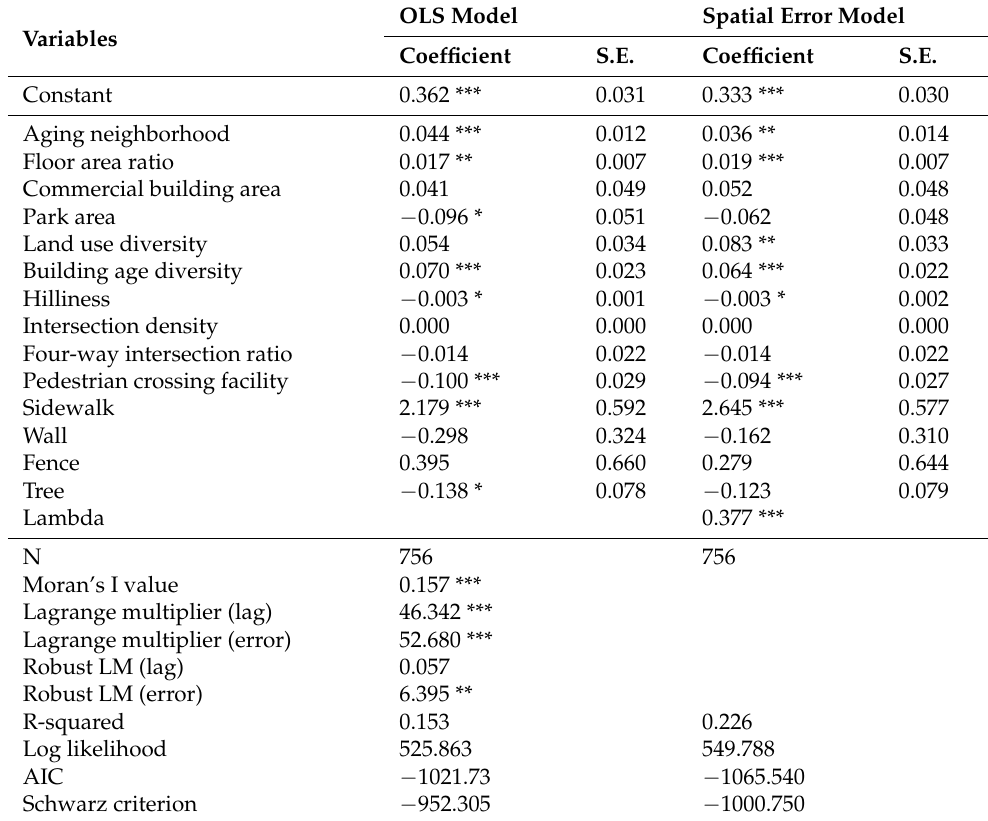
Table 2. Results of the OLS model and spatial error